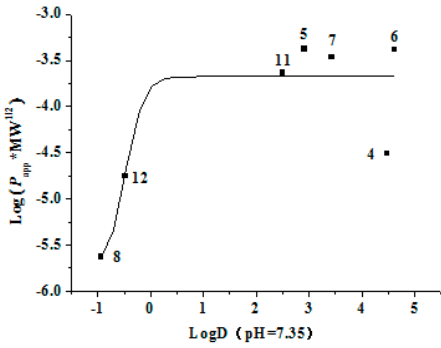
Figure 7. The relationship between log ( P app AP → BL × MW 1/2 ) and log D (pH = 7.35) for seven chalcones ( 4 – 8 , 11 , and 12 ).